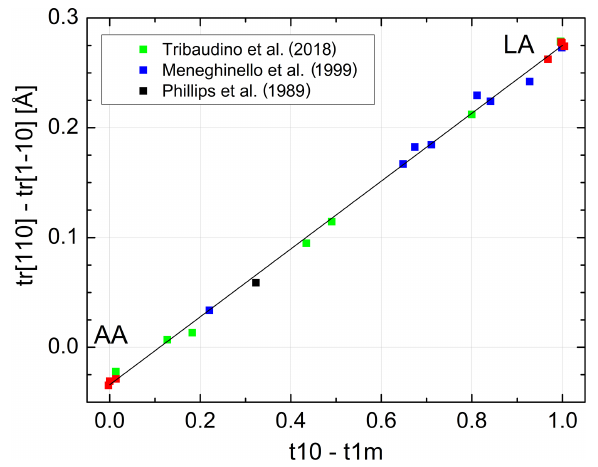
Figure 6. Linear variation in (cid:49) tr [ 110 ][ Å ] ≡ tr [ 110 ]− tr [ 1 ¯ 10 ] as a function of (t 1 0 − t 1 m) (symbols as in Fig. 5). The sizes of the data points comply with the estimated errors.